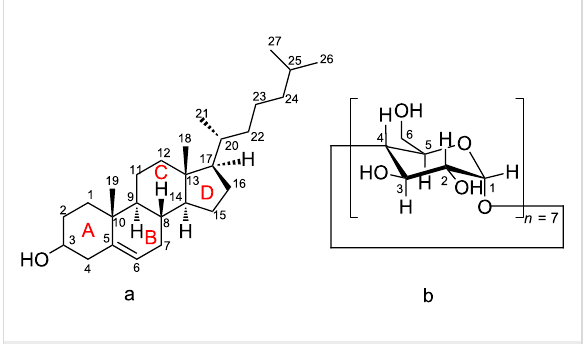
Figure 1: Schematic representation of (a) the cholesterol molecule; (b) the β -cyclodextrin molecule.